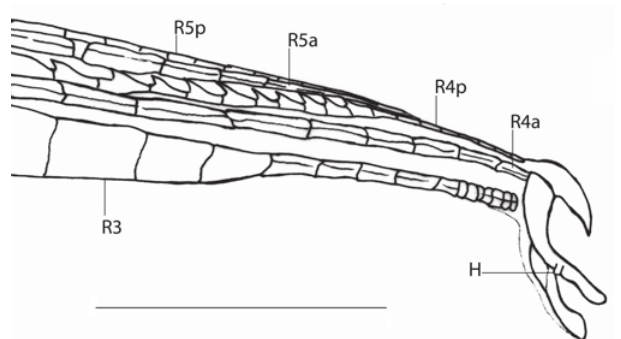
Fig. 39. Gonopodium tip of Phalloceros lucenorum , MCP 12197. R3, R4a, R4p, R5a, R5p indicate gonopodial rays. Scale bar 1